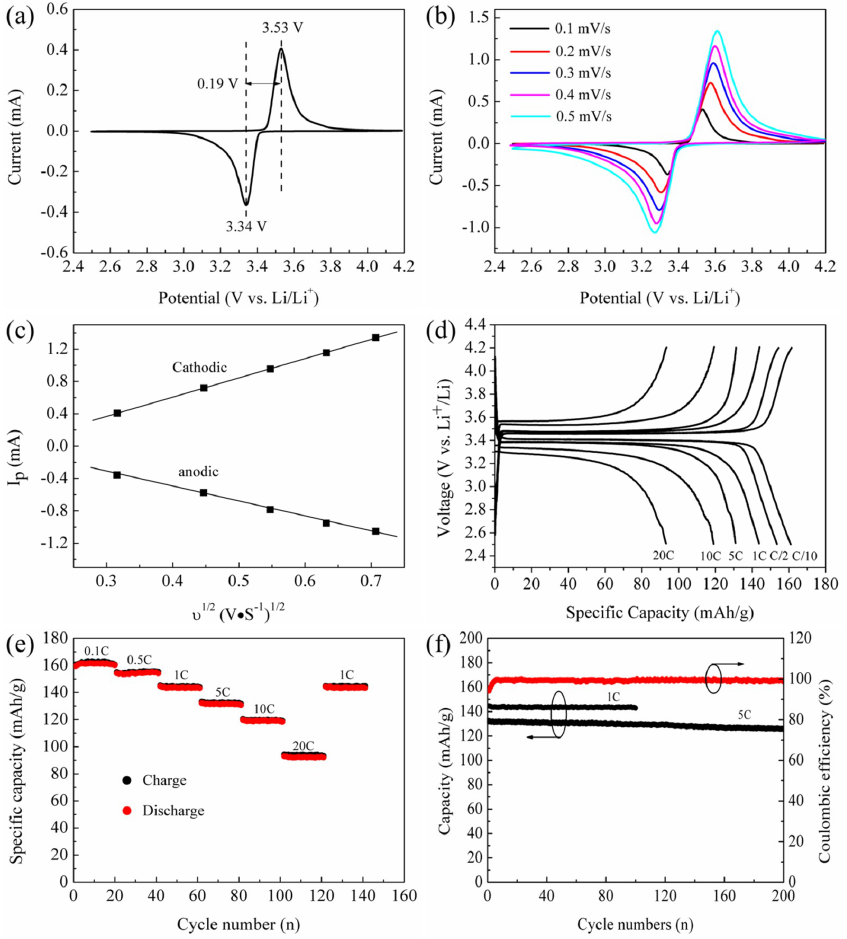
Figure 5. ( a ) Typical CV curve of LiFePO4/C composite at scan rate of 0.1 mV/s; ( b ) CV curves of LiFePO4/C composite at scan rates of 0.1–0.5 mV/s; ( c ) linear response of the peak current (I p ) as a function of the square root of scanning rate (ν); ( d ) charge and discharge profiles of LiFePO4/C composite in the potential region from 2.5 to 4.2 V at various rates; ( e ) rate performance curves from 0.1 C to 20 C; and ( f ) cycling performance combined with coulombic efficiency at 1 C and 5 C.